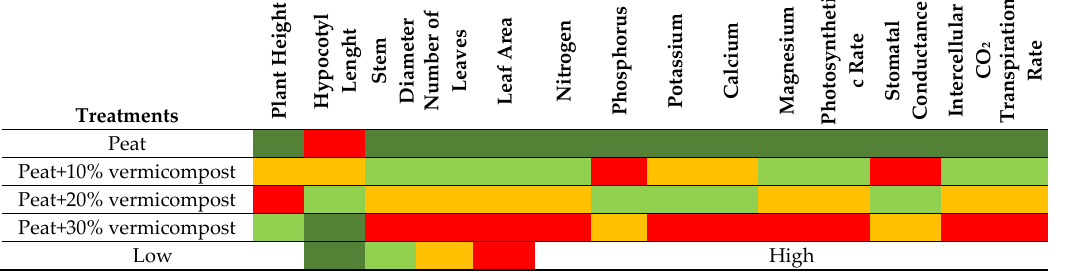
Figure 6. Relationships of peat–vermicompost substrates according to biometric parameters, macroelement content and photosynthetic parameters in cucumber seedling leaves.